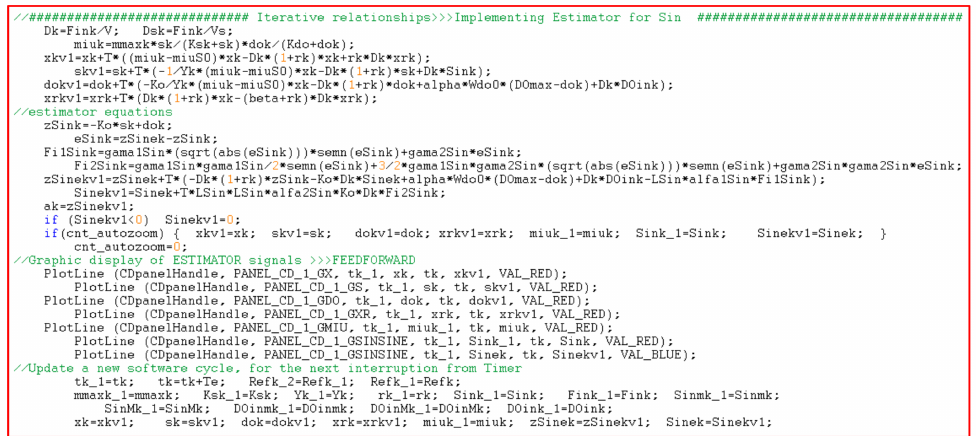
Figure 8. The source code for the implementation of the SMO super-twisting algorithm used for the estimation of influent substrate